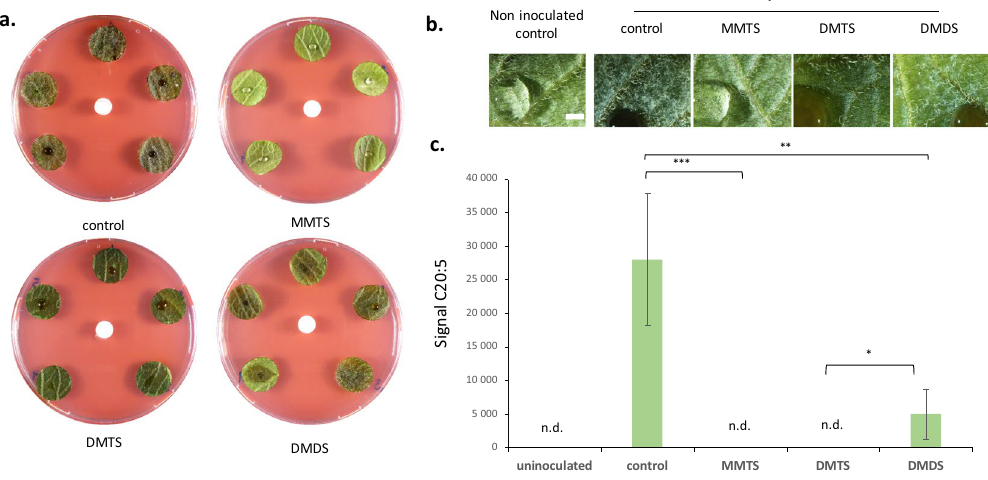
Figure 1. Sulfur-containing VOCs restrain late blight disease in potato leaf discs. ( a ) Leaf discs from Bintje adult plants (n = 5) were inoculated with P. infestans (Rec01) and simultaneously exposed to 1 mg MMTS, DMTS, or DMDS (or solvent used as control) loaded on a central silicone septum. Pictures are shown after 6 days of incubation and are representative of 3 independent assays. ( b ) Binocular pictures of co-treated leaf discs as described. Scale bar = 1 mm. ( c ) Quantification of oomycete infection by dosage of P. infestans fatty acids in leaf samples. Significant differences according to an ANOVA test are marked by asterisks: * p < 0.05; ** p < 0.01 and *** p < 0.001. n.d. = not